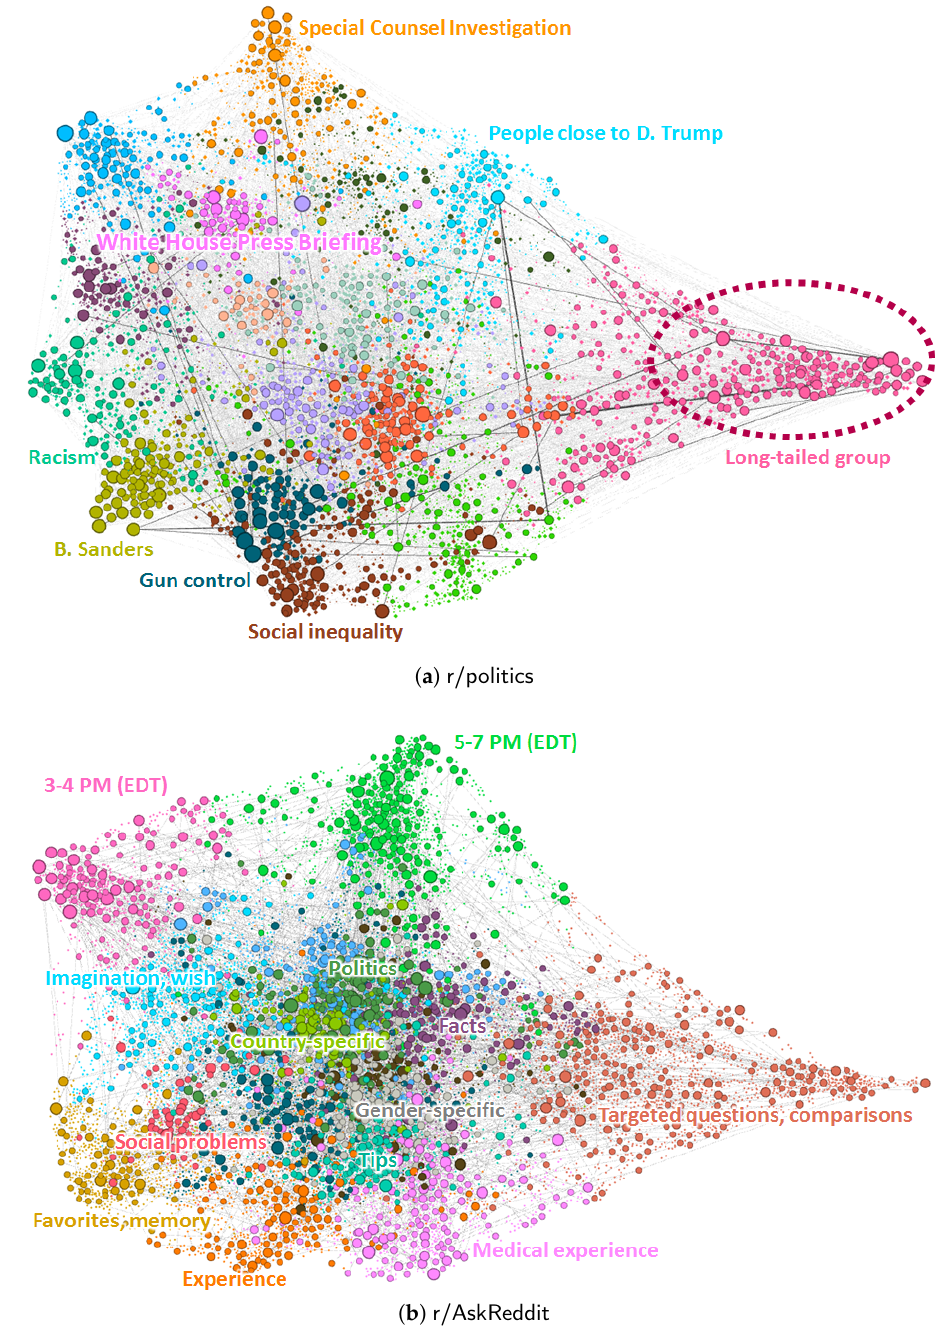
Figure 4. Visualizing the user replying network for Reddit